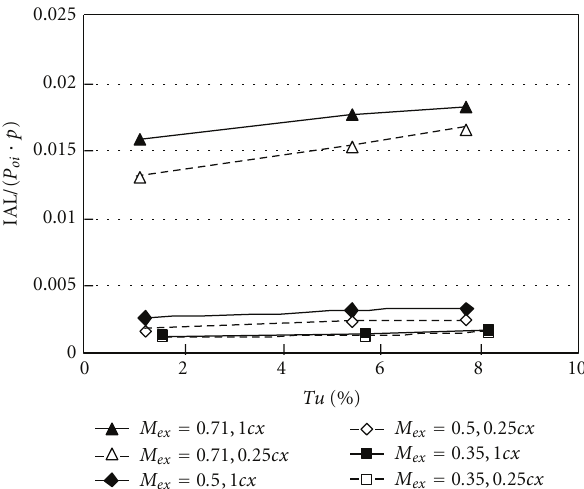
Figure 16: Comparison of normalized integrated aerodynamic loss as dependent upon inlet turbulence intensity for a smooth, cambered vane